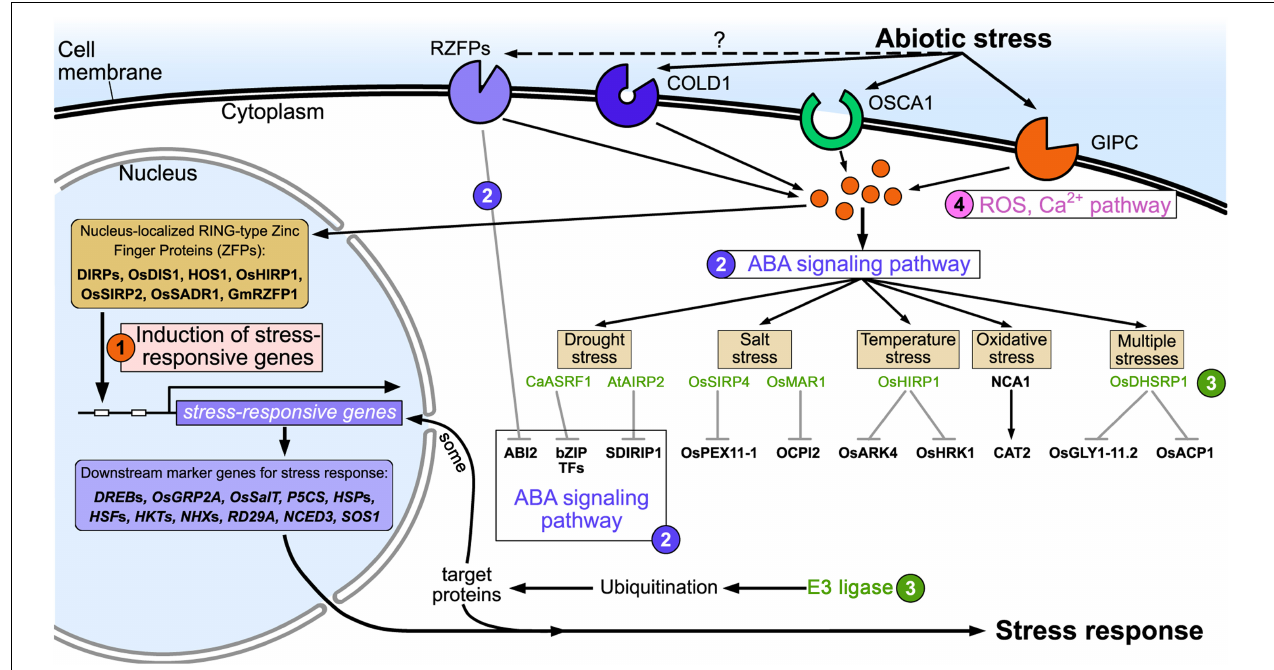
FIGURE 2 | Schematic of RING zinc finger protein regulation of plant adaptation to abiotic stress. (cid:192) Expression of stress-responsive genes; (cid:193) ABA pathway; (cid:194) ubiquitination pathway; (cid:195) Ca 2 + and ROS signaling pathway.